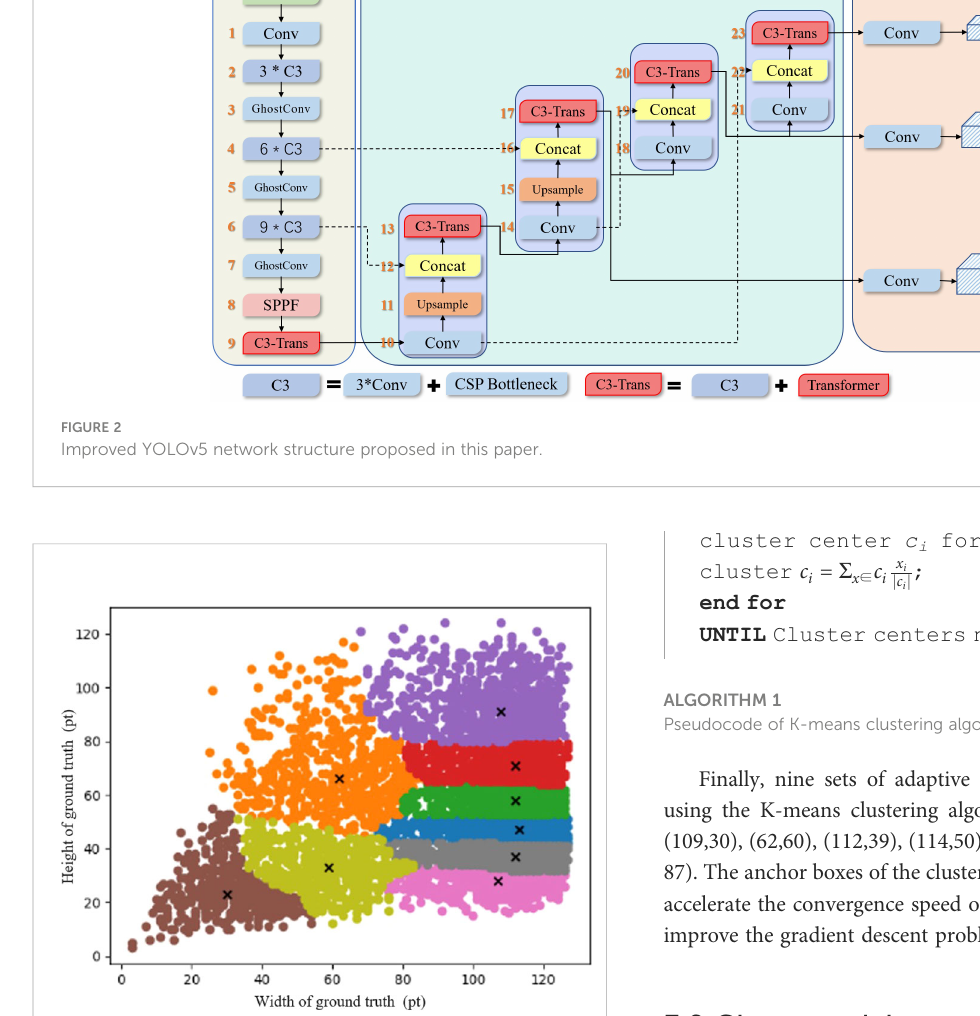
FIGURE 3 Result of ship dataset using K-means clustering. The x - coordinate is the width of the ground truth bounding box and the y -coordinate is the height of the ground truth bounding box.